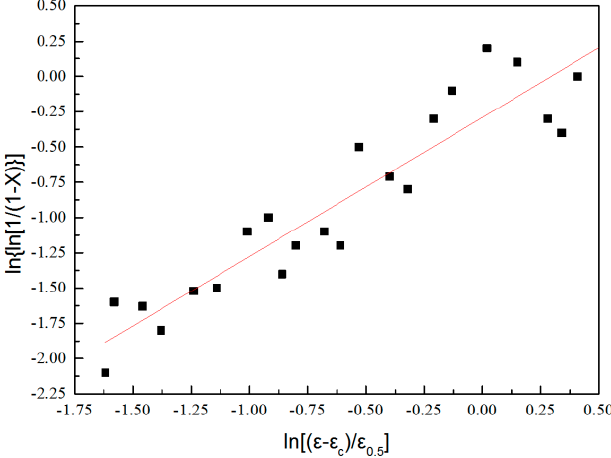
Figure 9. Relation between ln { ln [1 / (1 − X )]} and ln [( ε − ε c ) / ε 0.5 ] at various deformation temperatures. Figure 9. Relation between ln { ln [1/(1 − X )]} and ln [( ε − ε c )/ ε 0.5 ] at various deformation temperatures. The grain size of the microstructure calculated according to the GH4169 high-temperature dynamic Figure 9. Relation between ln { ln [1/(1 − X )]} and ln [( ε − ε c )/ ε 0.5 ] at various deformation temperatures. recrystallization metallographic structure diagram is shown in Table 4. According to the data in the Table 3. Strain rate 𝜀(cid:4662) , peak strain ε p , dynamic recrystallization volume fraction X , and lnZ at different table, the logarithmic fitting of D 2-drex and Z could be used to find the corresponding model parameters. temperatures. Table 3. Strain rate 𝜀(cid:4662) , peak strain ε p , dynamic recrystallization volume fraction X , and lnZ at different The fitted image is shown in Figure 10. The obtained dynamic recrystallization crystal mass equation temperatures. is shown in Equation (25).